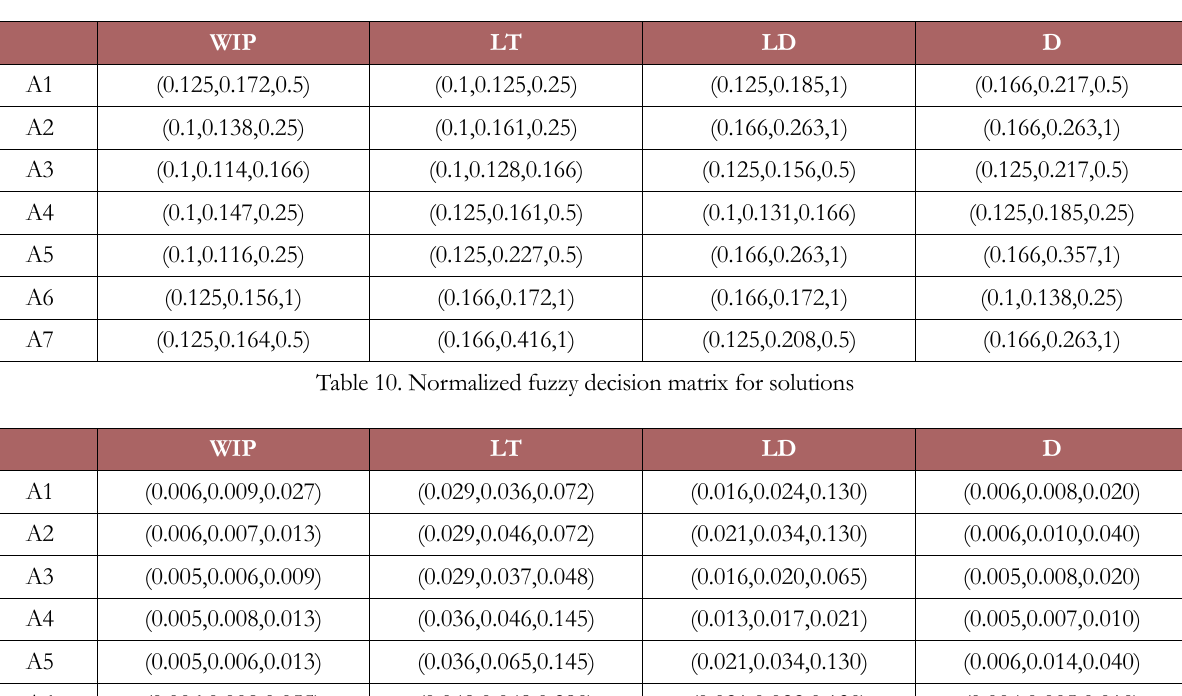
Table 9. Aggregate fuzzy decision matrix for solutions